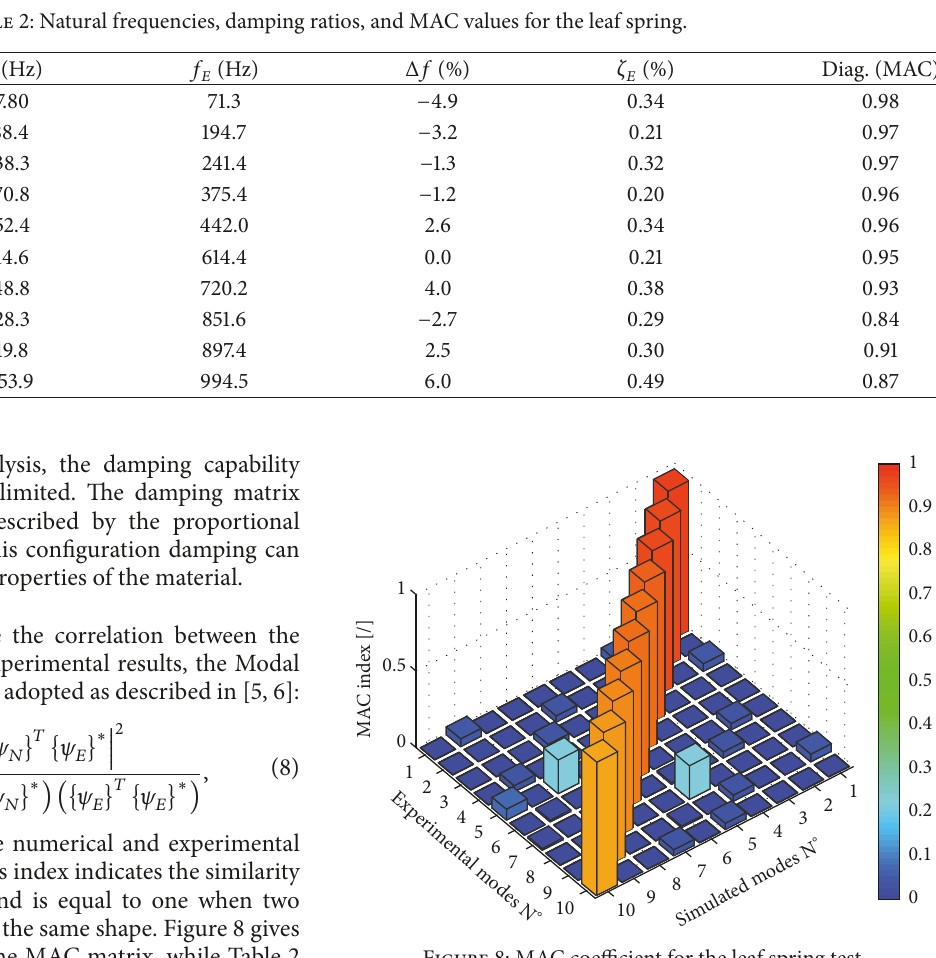
Figure 8: MAC coefficient for the leaf spring